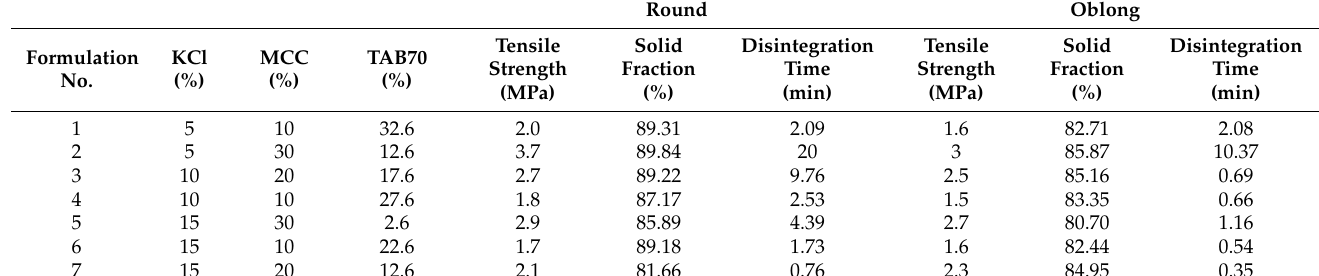
Table 5. Factors and responses for the mixture design of round and oblong tablets.